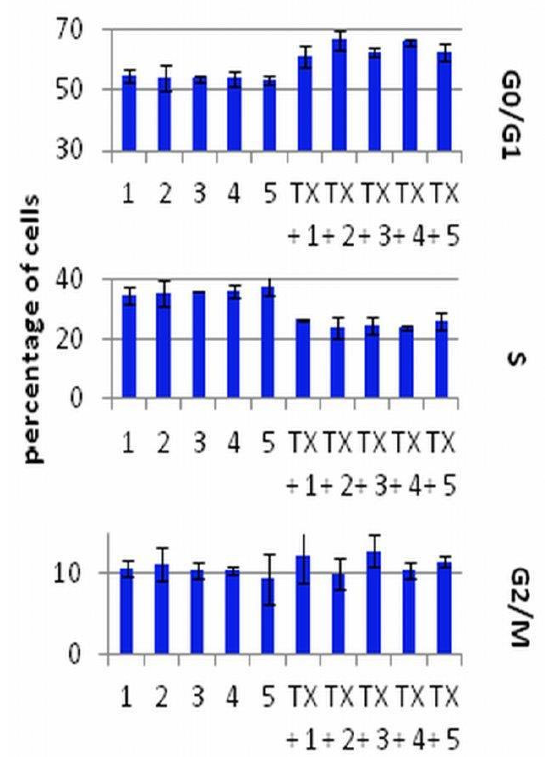
Figure 3. The cell cycle analysis of MCF-7 cells preincubated for 24 h with vitamin D compounds and treated with tamoxifen. TX: tamoxifen (1 µg/mL); 1: control (EtOH); 2: calcitriol; 3: PRI-2191; 4: PRI-2201; 5: PRI-2205. Mean ± SD (standard deviation) is presented. Data were analyzed in WinMDI 2.9 program